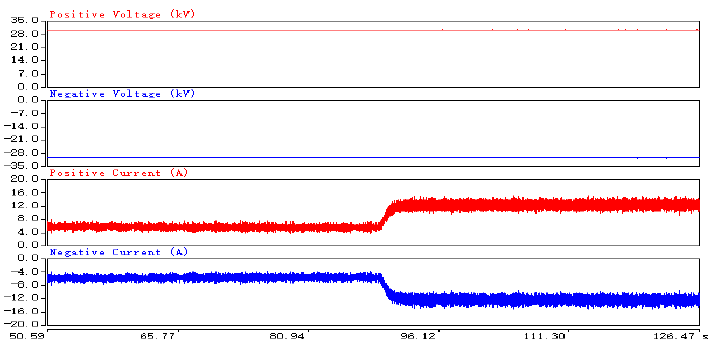
Figure 32. Power limiting mode to MPPT operation mode.